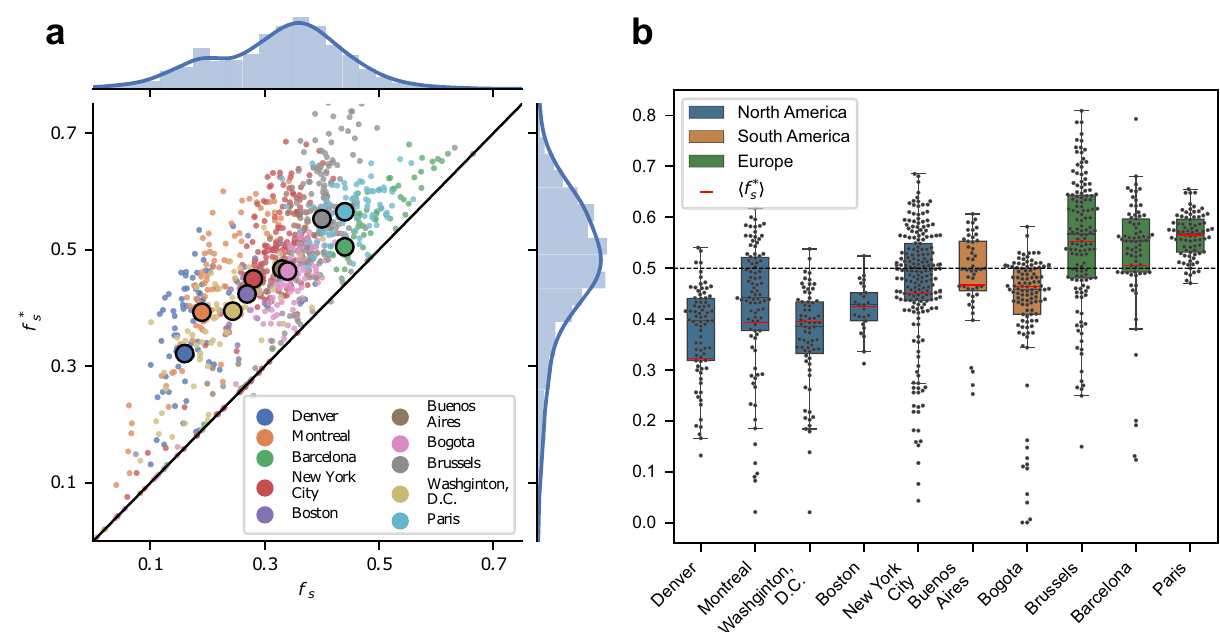
Fig. 5 Distribution of public space, post-intervention at τ = 2. a The scatterplot compares the amount of sidewalk share before and after the proposed intervention. Clearly, opening streets pedestrians to promote social distancing also has an effect on the overall distribution of space between pedestrians and cars, as illustrated here (the solid line with slope 1 is a guideline to the eye). b The box-plots (median in dark gray) display the distribution of space for all the cities for which the sidewalk geometries were gathered, now considering the gains in sidewalk share. To ease comparison, cities in the x-axis are sorted in the same order as in Fig. 1 in the same order. The average sidewalk share 〈 f s 〉 is marked in